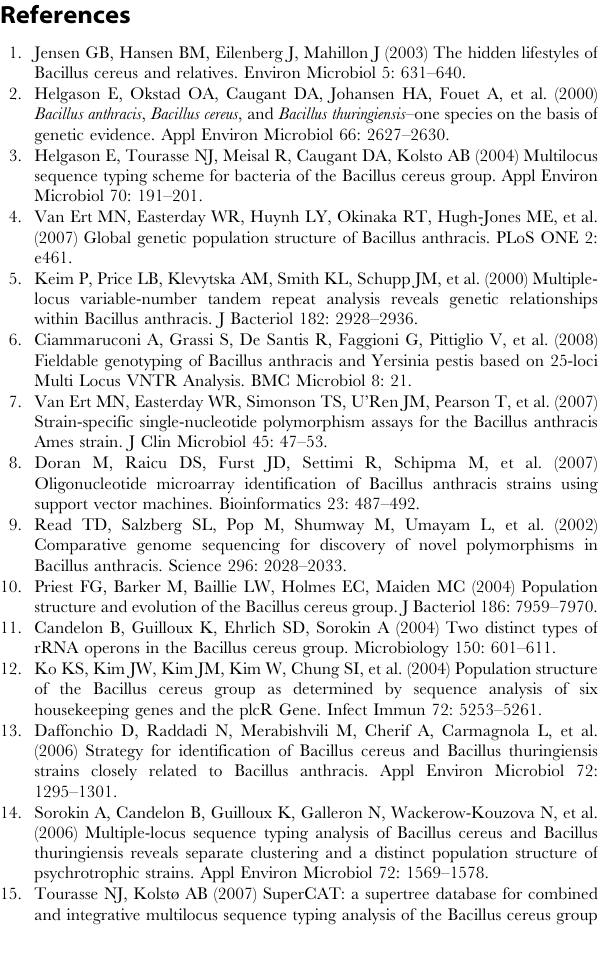
Table S3 Reference genomic sequence used to design the BDRD-01 resequencing array (RA). Table S4 Proportion bases called (QS 30) for each B. anthracis Table S5 Bacillus resequencing